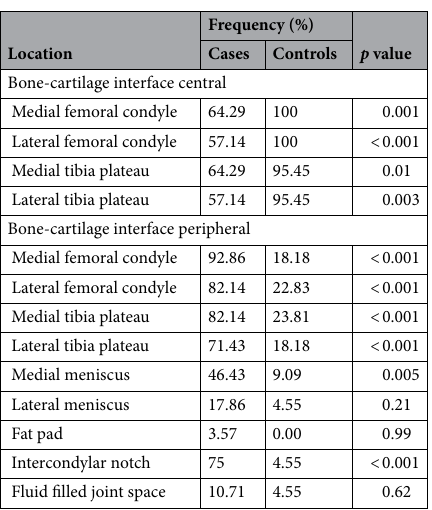
Table 6. Frequency of regions of discriminative high activation on the saliency maps at anatomic location of the knee for case subjects with total knee replacement (TKR) and control subjects without TKR computed using the DESS